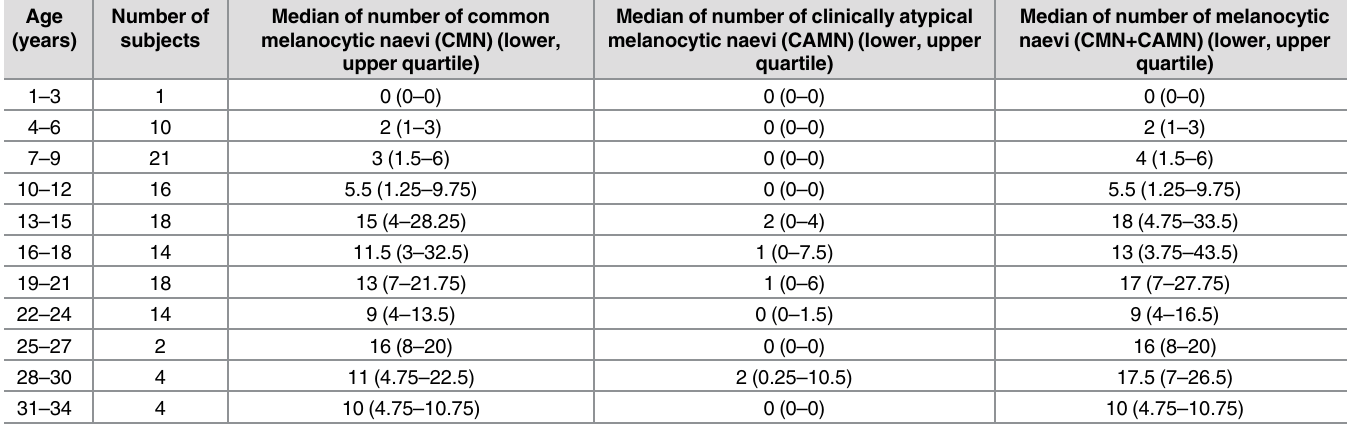
Table 1. Prevalence of common and clinically atypical naevi by age groups among monozygotic twin pairs (N = 122). Age (years)